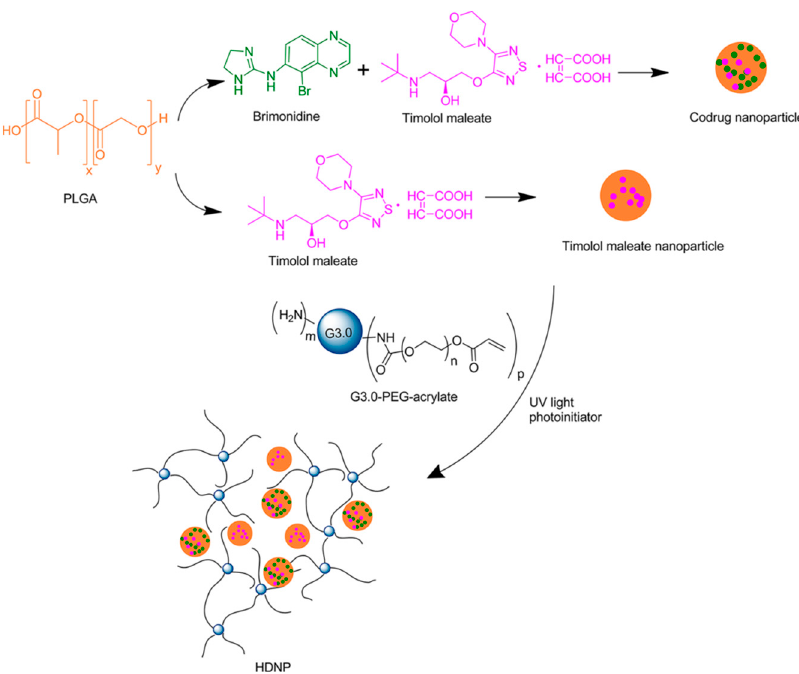
Figure 22. Formation of hydrogels incorporated with brimonidine- and timolol maleate-loaded nanoparticles (HDNP). Reprinted with permission from [51], Copyright © 2012 American Chemical Society. PLGA, poly(lactic-co-glycolic acid).